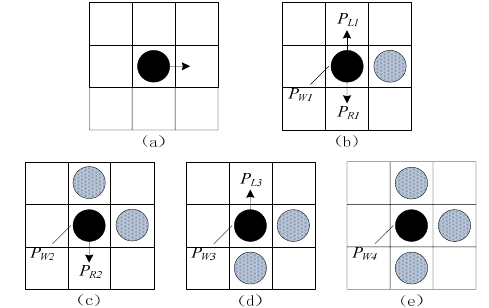
Fig. 2. All the possible configurations that a single right walker may encounter.